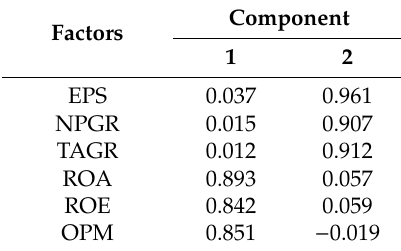
Table 2. Rotated component